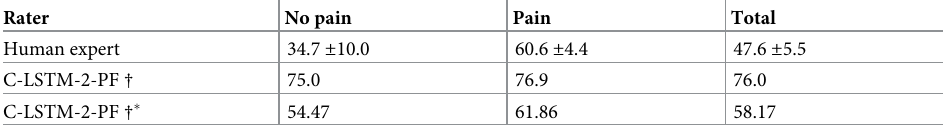
Table 7. F1-scores (%) on the 25 clips of the expert baseline. The C-LSTM-2-PF † instance was trained on PF but never on EOP(j). Asterisk: results on the entire EOP(j) dataset for